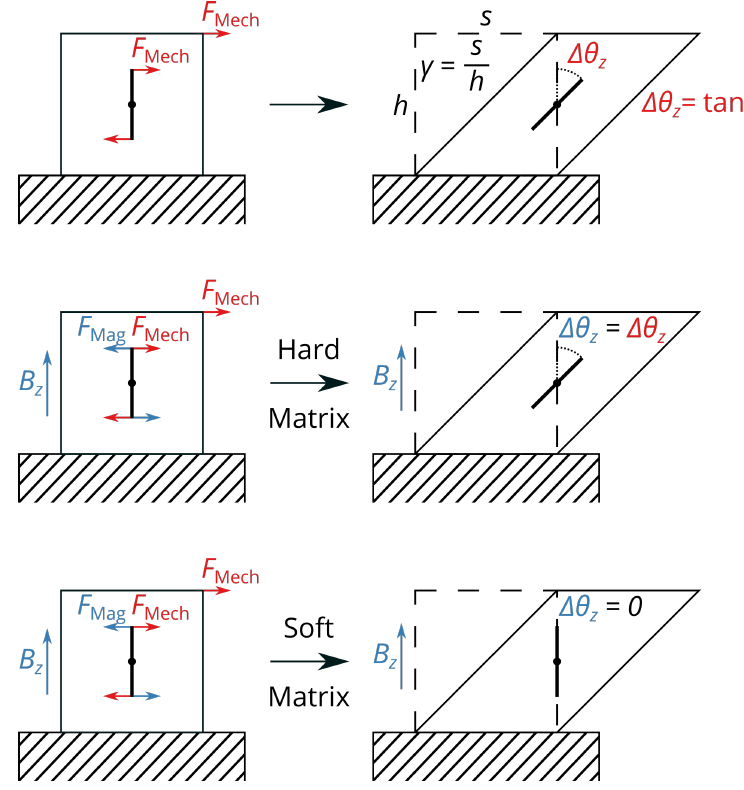
Figure 6. A rod magnet inside an elastic matrix material will rotate by ∆ θ z = tan ( γ ) when the matrix material is sheared by γ . When a magnetic field is applied, two extreme cases for a hard or a soft matrix material can be described, which leads to different rotation angles ∆ θ z